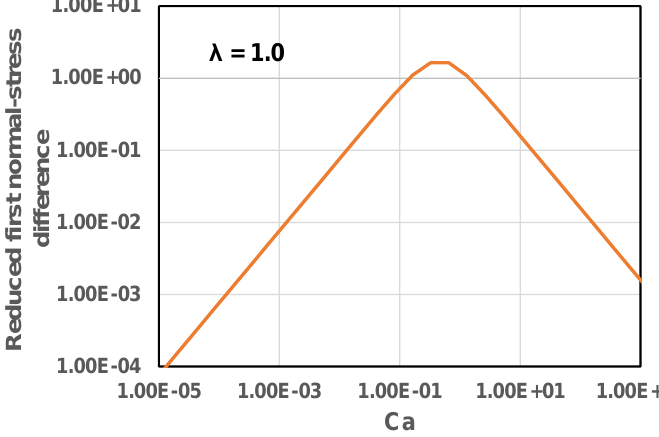
Figure 19. Reduced first normal stress difference N 1 r / φ versus Ca , keeping λ = 1.